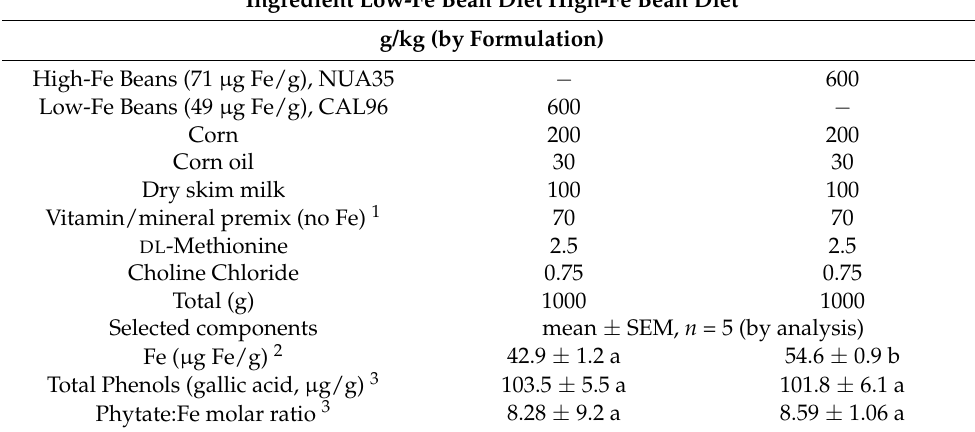
Table 1. Composition of experimental